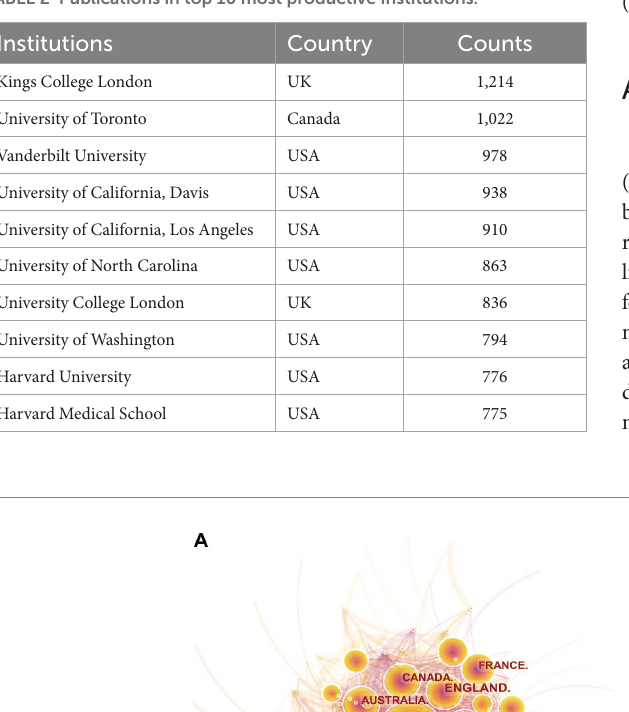
TABLE 2 Publications in top 10 most productive Institutions.